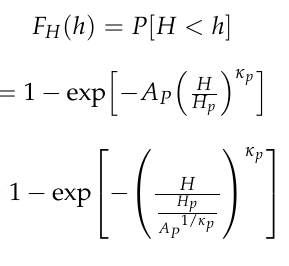
Figure 13. Venn diagram showing the area in sample space on R − S plane corresponding to the failure of armor block of rubble mound breakwater.